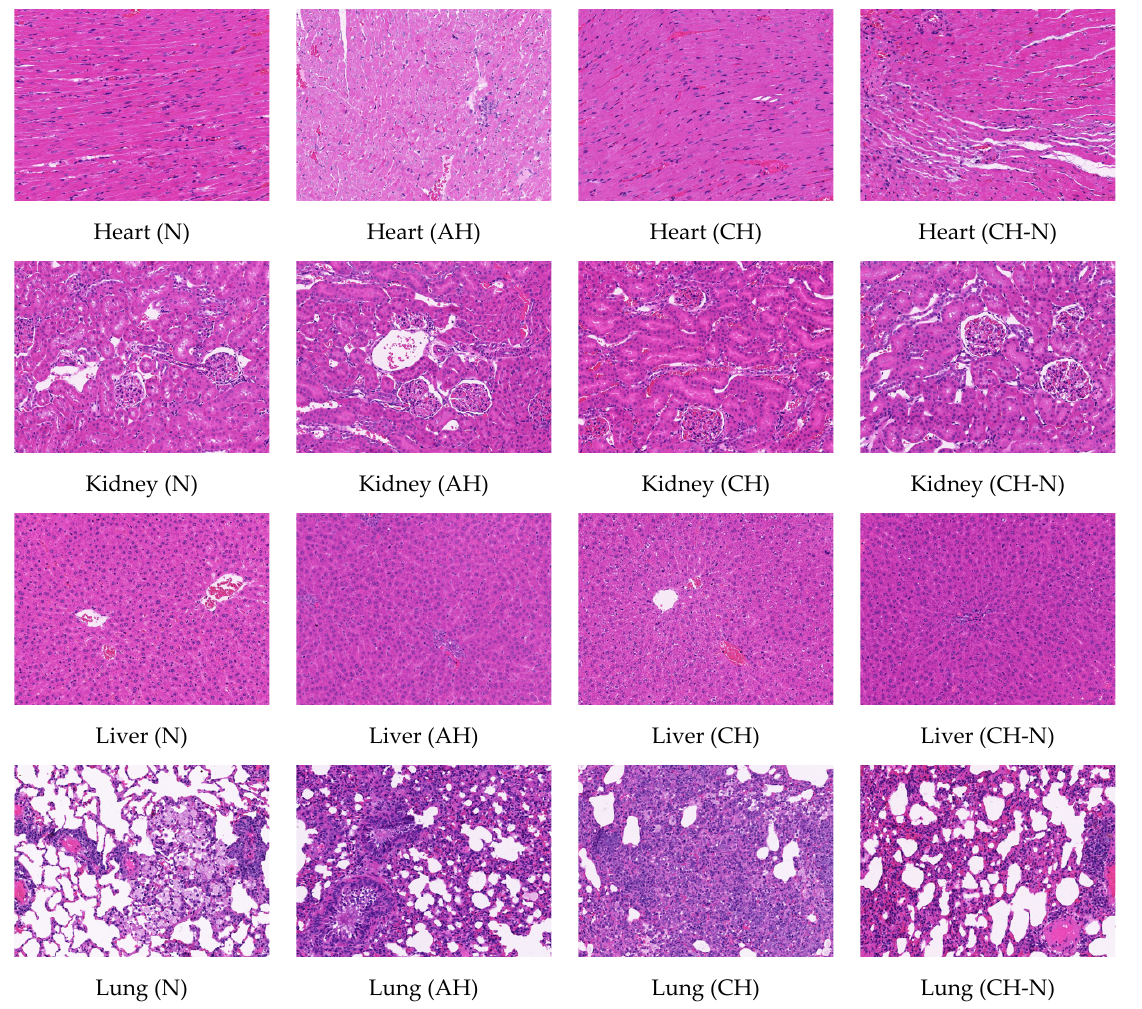
Figure 3. Effects of high-altitude hypoxia on heart, kidney, liver, and lung tissue in rats (HE, 200 × ). Note: N, AH, CH, CH-N refer to the normoxia group, acute hypoxia group, chronic hypoxia group, and chronic hypoxia to normoxia group, respectively.